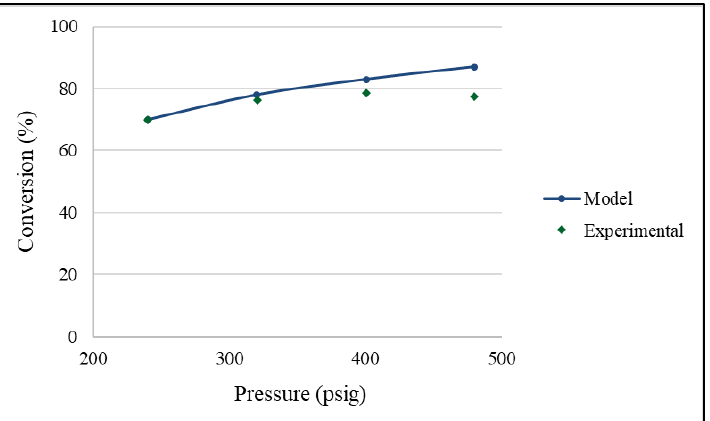
Figure 2. Effect of inlet hydrogen pressure on the conversion of 4-propylguaiacol. Reaction condi- tions: Temperature, 400 ◦ C; gas phase, hydrogen; liquid phase, 4-propylguaiacol; liquid flow rate, 0.03 mL · min − 1 ; gas flow rate, 0.09 mL · min − 1